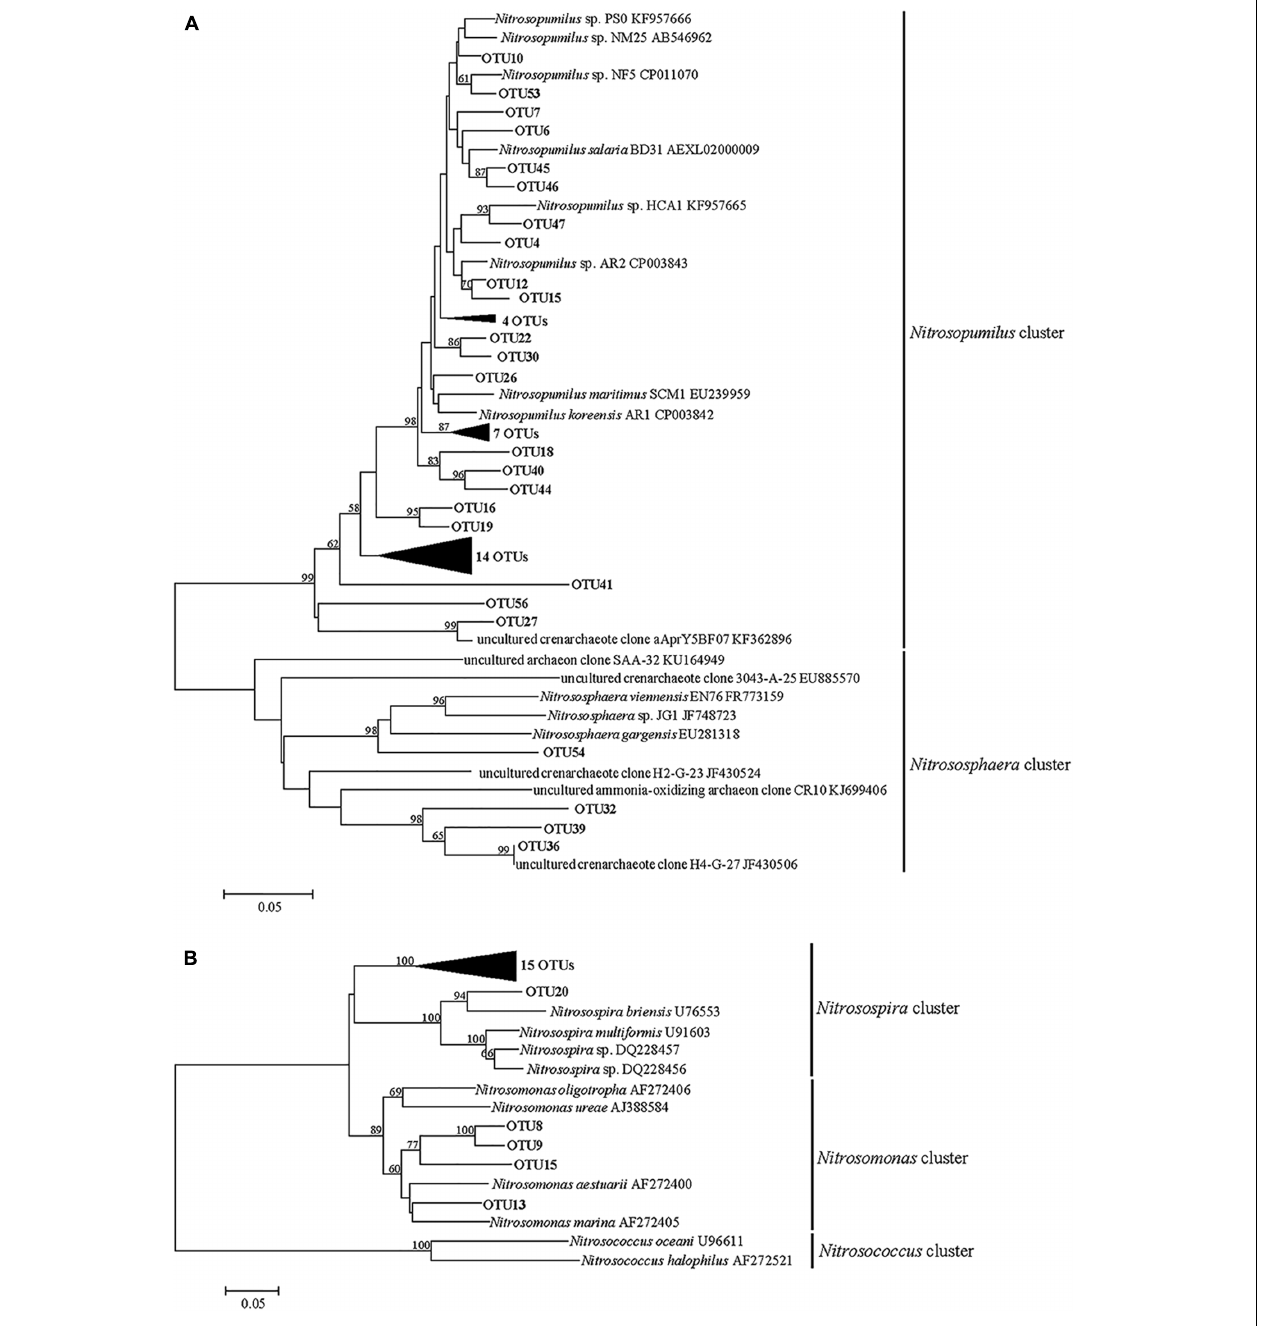
FIGURE 3 | Neighbor-joining phylogenetic tree of archaeal (A) and bacterial (B) amoA gene sequences. Bootstrap values greater than 50% of 1000 resamplings are shown near nodes. The scale bar indicates 0.05 nucleotide substitutions per nucleotide